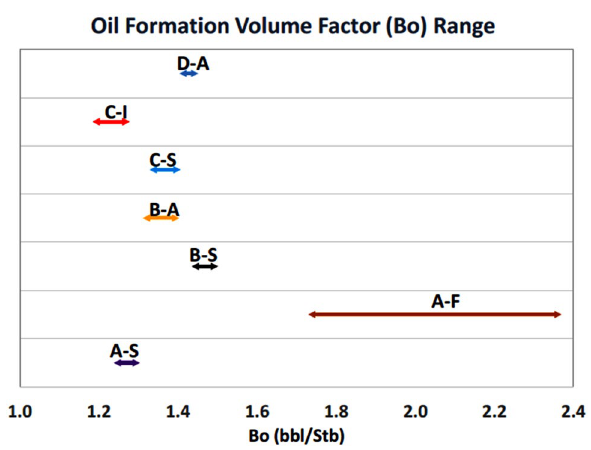
Fig. 4 STOIIP calculation difference based on PVT sample of each